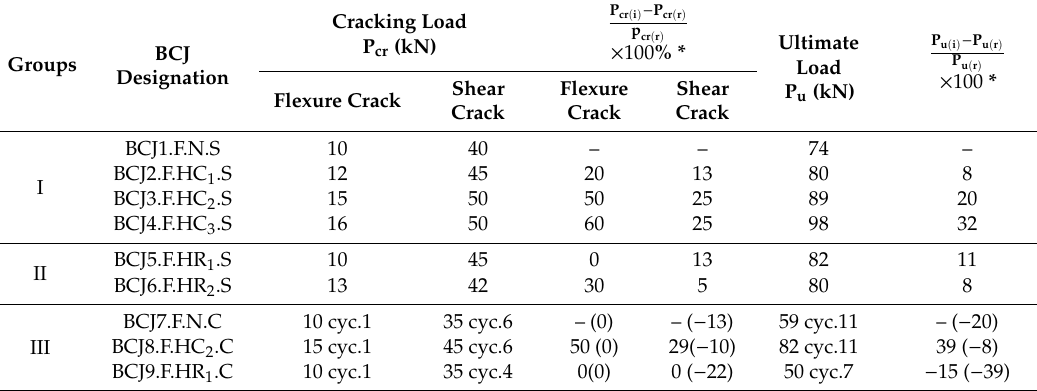
Table 4. Summary of the experimental